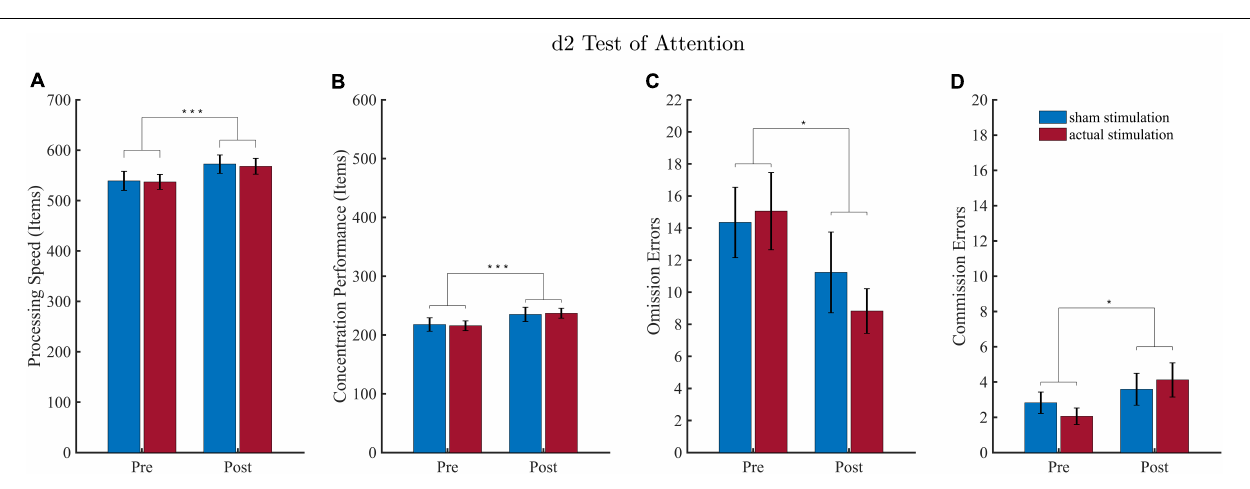
ERO power values revealed a significant main effect of “Block” [ F ( 1 , 18 ) = 8.26, p = 0.010, η p 2 = 0.31], but no